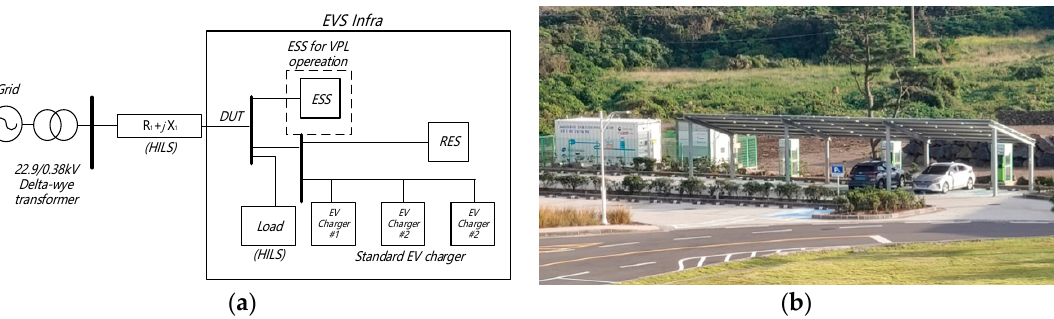
Figure 10. Configuration of EVC infrastructure. ( a ) Single diagram. ( b ) Test Bed. Table 3. Real test Data.